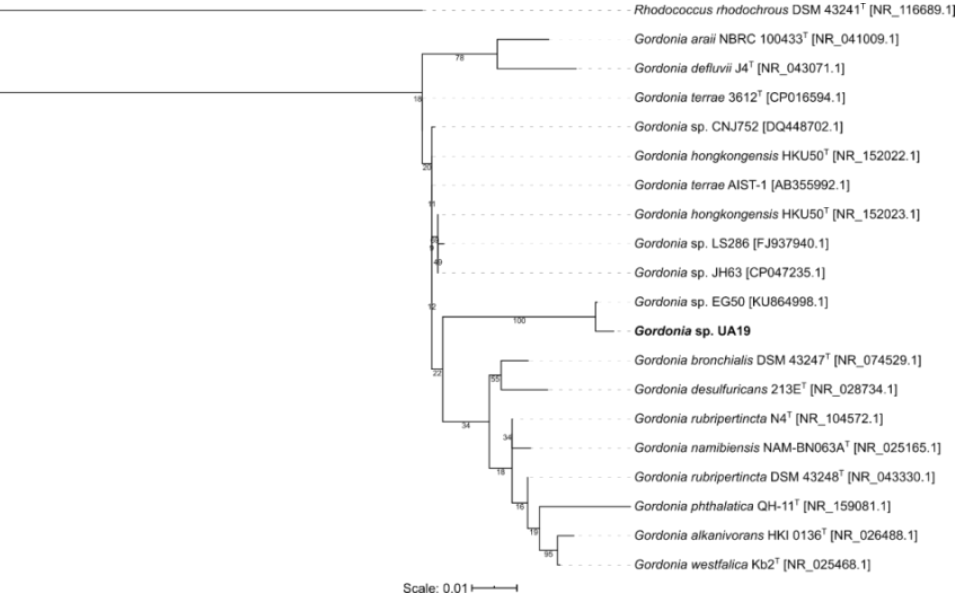
Figure 3. Maximum-likelihood tree of 19 Gordonia representatives and one Rhodococcus strain as an outgroup. Bootstrap values (100 resamples) are given in percent at the nodes of the tree. The isolate Gordonia sp. UA19 obtained in this study is presented in bold.